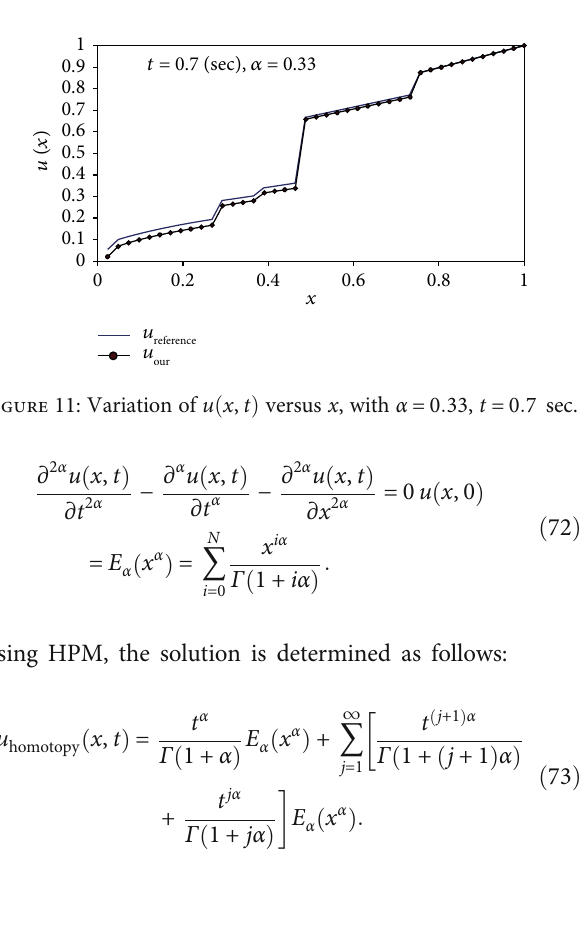
Figure 10: Variation of u ð x , t Þ versus x with α = 1 , t = 0 : 1 sec .